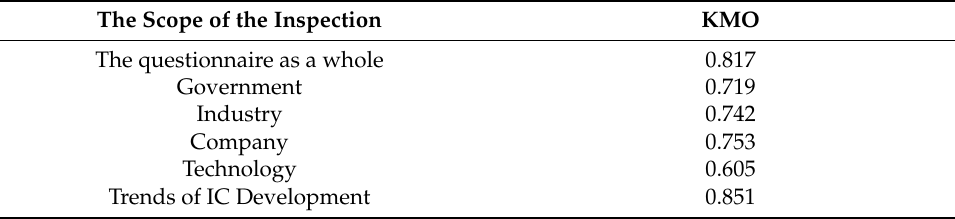
Table 4. The result of Kaiser-Meyer-Olkin.